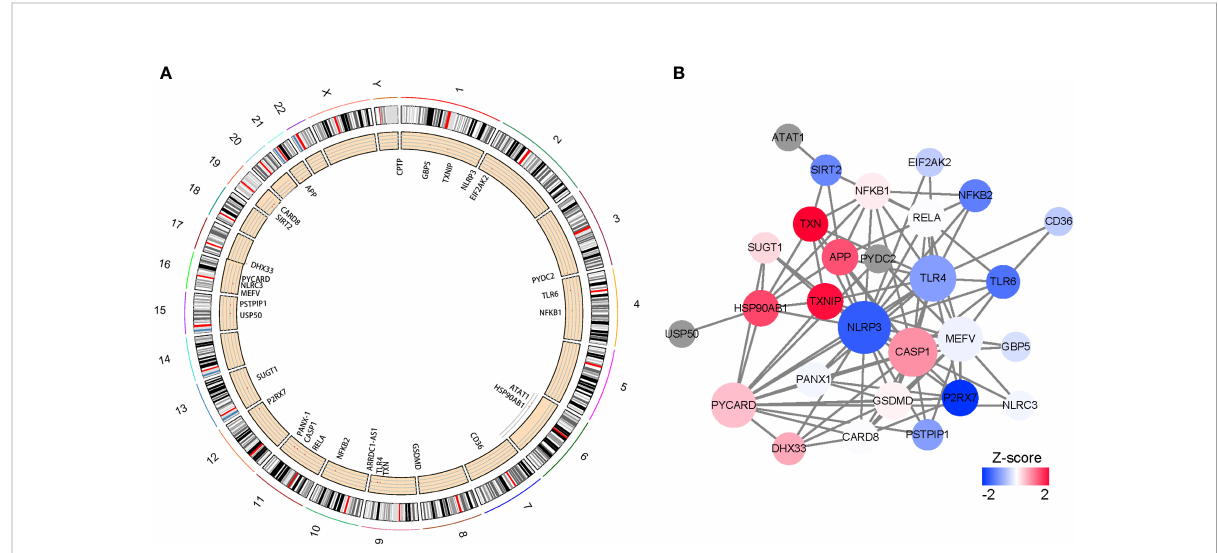
FIGURE 1 Characteristics and interactions of 25 NLRP3 in fl ammasome-related genes. (A) Circos plot showing the location of genes in 24 chromosomes. (B) protein-protein interaction networks of DEGs. Red represents positive correlations while blue represents negative